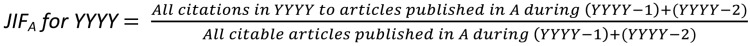
JIF Calculation formula.